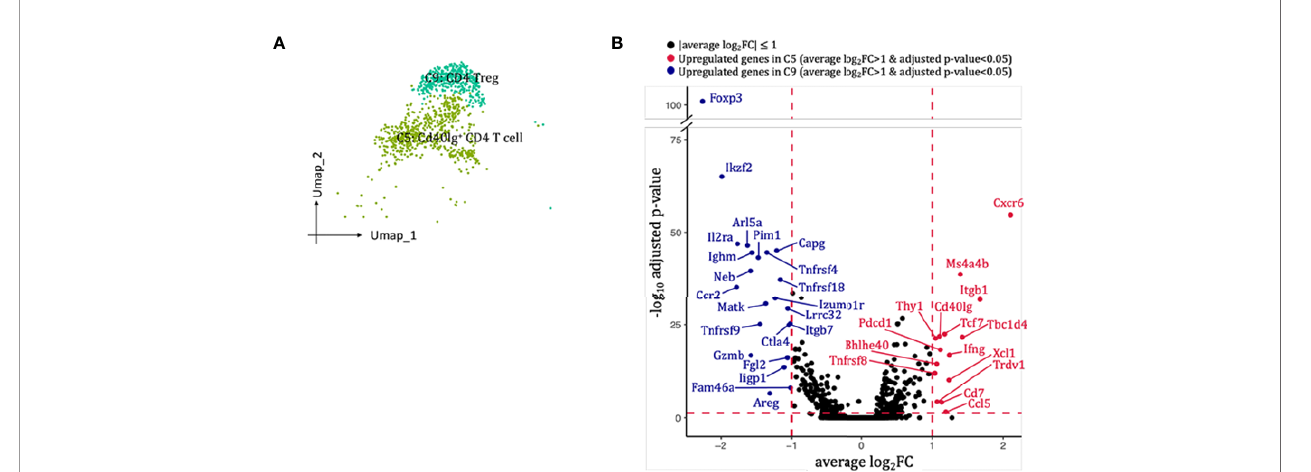
FIGURE 7 | CD4 T cells presented in the allografted kidneys. (A) Integrated UMAP projection of the two CD4 T cells clusters identi fi ed in the kidney grafts (clusters 5 and 9), colored according to cluster designation. Cell identities are annotated on the clusters. (B) Volcano plots of the differentially modulated genes in C5 versus C9. The x axis speci fi es the average log 2 FC and the y axis speci fi es the negative logarithm (base 10) of the adj_p value. Red vertical and horizontal lines re fl ect the fi ltering criteria (avg_log 2 FC = ± 0.59 and adj_p value = 0.05). Red dots indicate genes induced in C5; blue dots indicate genes induced in C9. Genes passing fi ltering criteria are labeled. UMAP, Uniform Manifold Approximation and Projection; avg_log 2 FC, average log 2 fold change; adj_p value, adjusted p